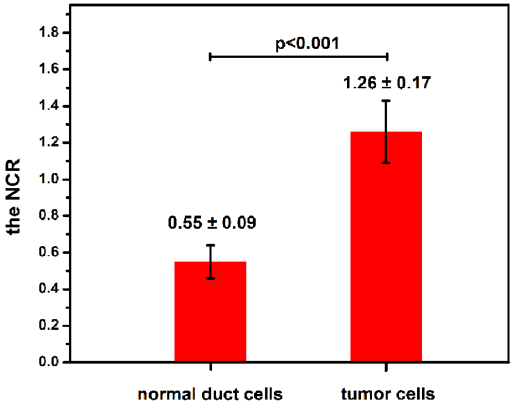
Figure 6. NCR of normal duct cells and tumour cells (n = 30, p <